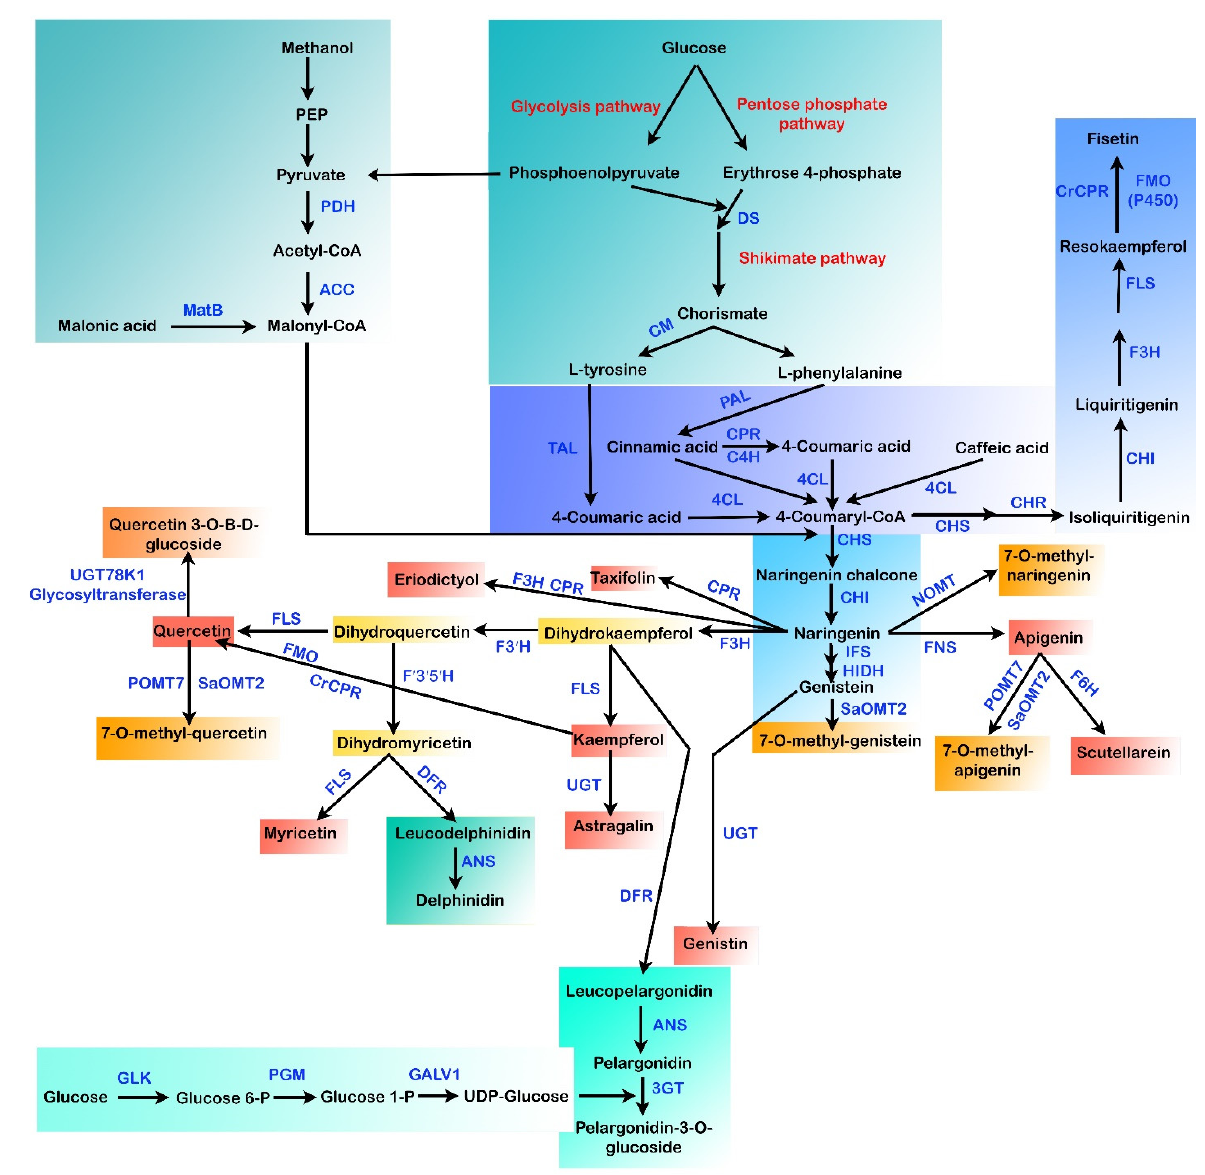
Figure 3. Different biosynthetic pathways for the microbial production of flavonoids. MatB: malo-nyl-CoA synthetase, DS: 3-deoxy-D-arabinoheptulosonate 7-phosphate (DAHP) synthase, ACC: ac-